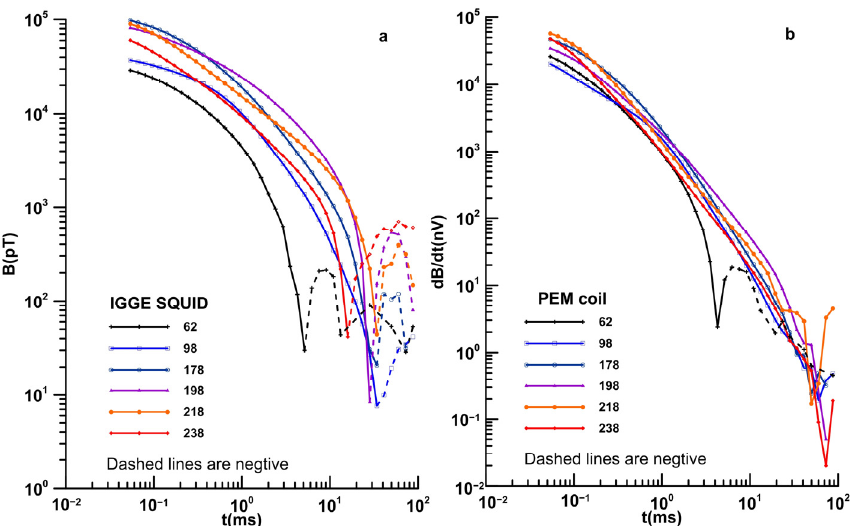
Figure 8. Comparison of SQUID magnetometer and coil decay curves (polarization phenomenon). ( a ) TEM decay curves of IGGE SQUID data; ( b ) TEM decay curves of PEM coil data.